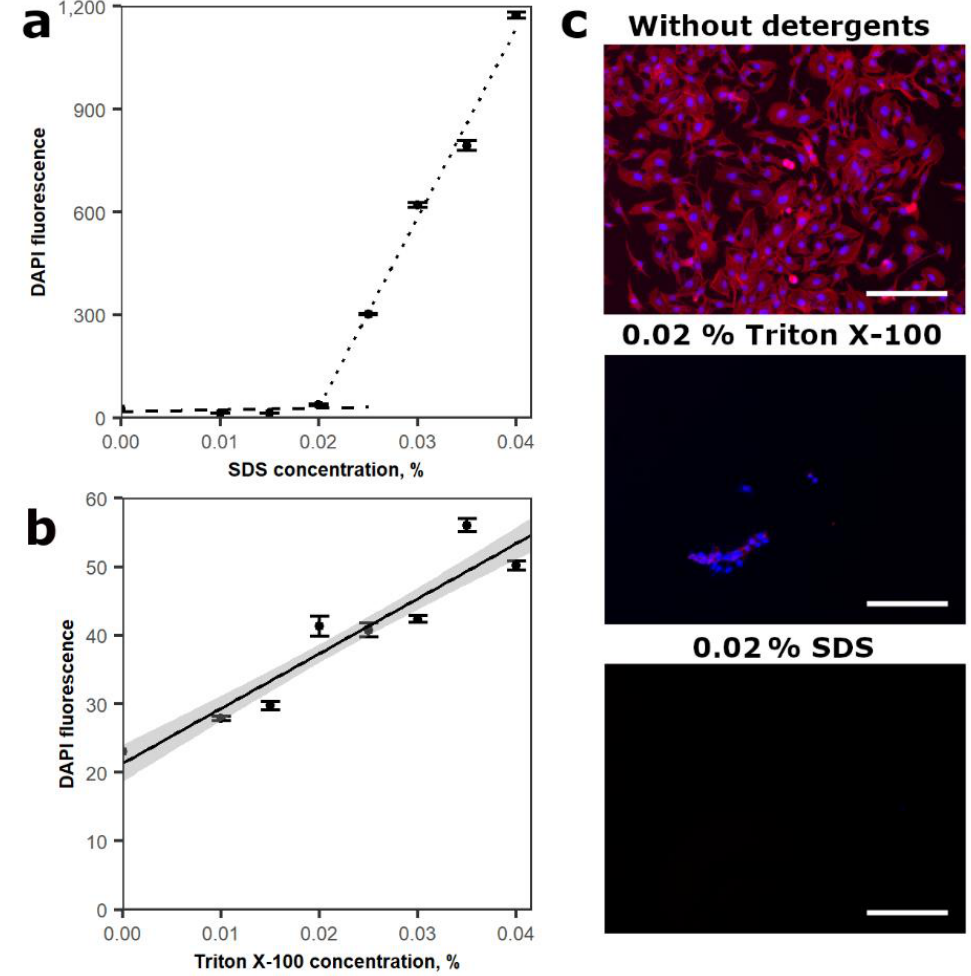
Figure 1. Assessment of efficiency of cell lysis buffers. ( a ) SDS concentration-dependent 2 µ g/mL DAPI fluorescence; ( b ) Triton X-100 concentration-dependent 2 µ g/mL DAPI fluorescence; ( c ) evaluation of the ability of SDS or Triton X-100 containing lysis buffers to dissolve DPSC cells. Immunofluorescence pictures depict cell nuclei (blue) and actin filaments (red). Values in graphs are shown as mean ± SD. n = 3, scale bar marks 200 µm.